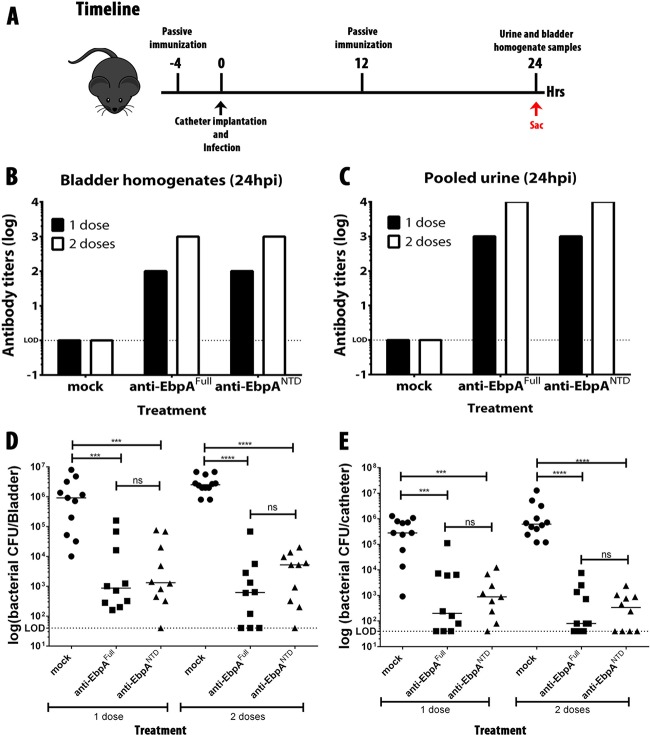
Passive immunization with anti-EbpAFull and anti-EbpANTD antibodies prevents E. faecalis CAUTI. Mice (n = 10) were given a dose of 100 µl of PBS sera or 100 µl of anti-EbpAFull or anti-EbpANTD with a titer of 1 × 107. (A) Experimental timeline. Sac, time of mouse sacrifice. (B and C) Detection of EbpAFull and EbpANTD antibodies in bladder (B) and in urine (C) analyzed by diluting each sample 1:100 before serial dilution. (D and E) Prophylaxis treatment performed using 1 dose at 4 h prior infection (D) or 2 doses at 4 h prior infection and 12 h postinfection (hpi) (E). Values represent means ± SEM. The Mann-Whitney U test was used for mouse experiments; P < 0.05 was considered statistically significant. *, P < 0.05; **, P < 0.005; ***, P < 0.0005; ****, P < 0.00005; ns, values were not statistically significantly different. The horizontal bar represents the median value. The horizontal broken line represents the limit of detection (LOD) of viable bacteria. Animals that lost the catheter were not included in this work.